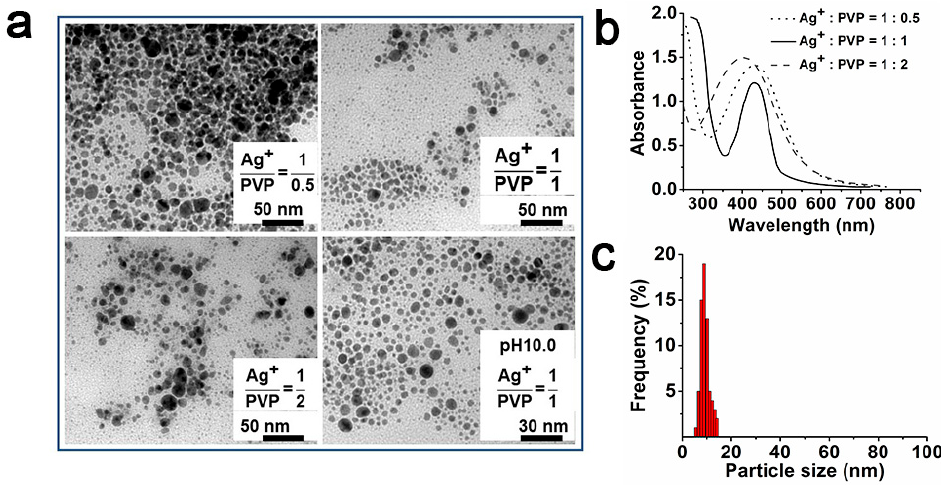
Figure 2. ( a ) TEM image of AgNPs synthesized by a purified protein with different mass ratios between Ag + and PVP; ( b ) UV-Vis spectra of AgNPs synthesized by a purified protein solution with different mass ratios between Ag + and PVP in presence of β -NADPH; ( c ) particle size distribution histogram of AgNPs synthesized with a Ag + /PVP mass ratio of 1:1 at a pH of 10.0 (874 particles in total).